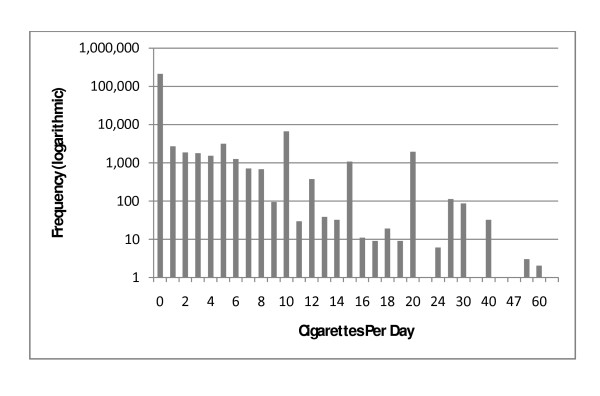
Distribution of Maternal Daily Cigarette Consumption in BC, 2001-06.